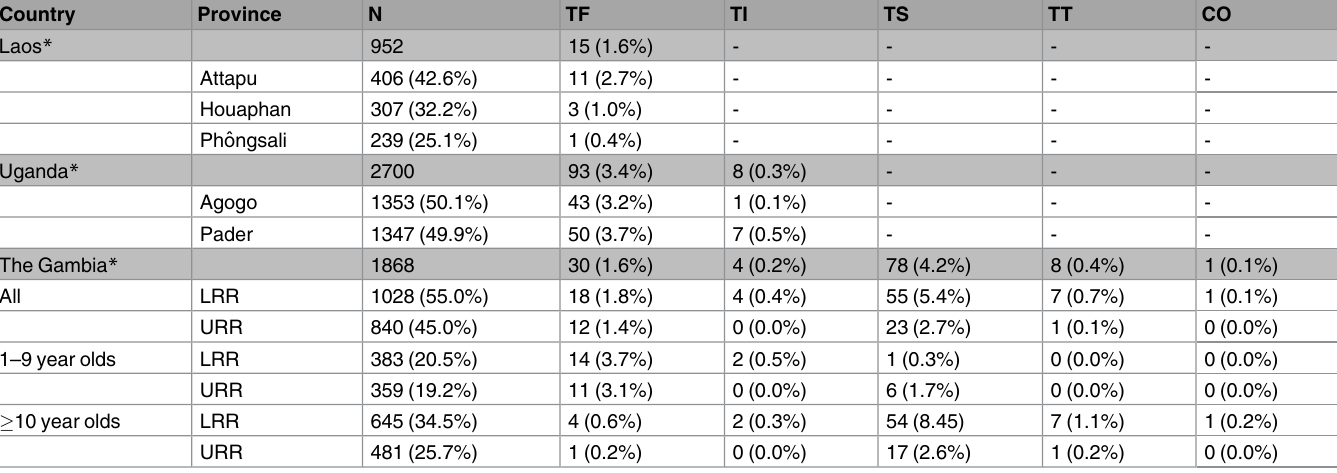
Table 1. Distribution of participants in three trachoma studies, including clinical signs.